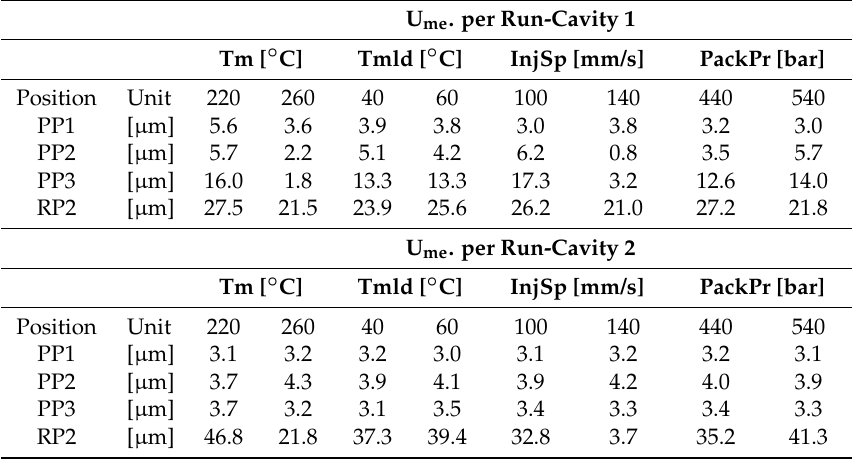
Table 6. Measurement uncertainty of the main effects (U me ) per parameter